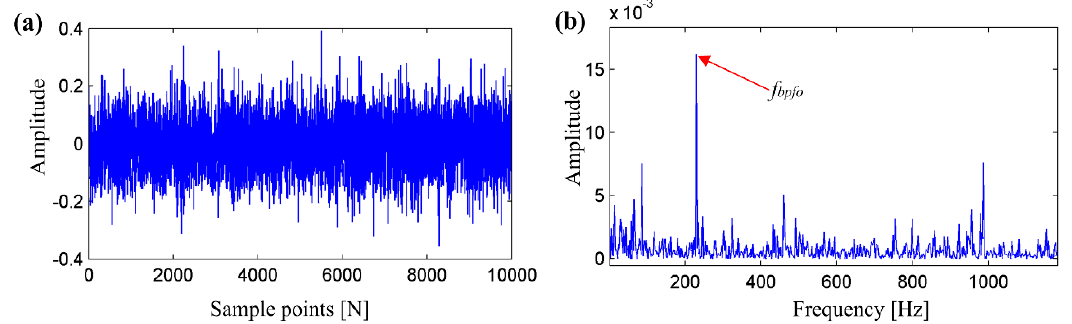
Figure 21. ( a )The original vibration signal of group 533; ( b ) The envelope demodulation spectrum of group 533.